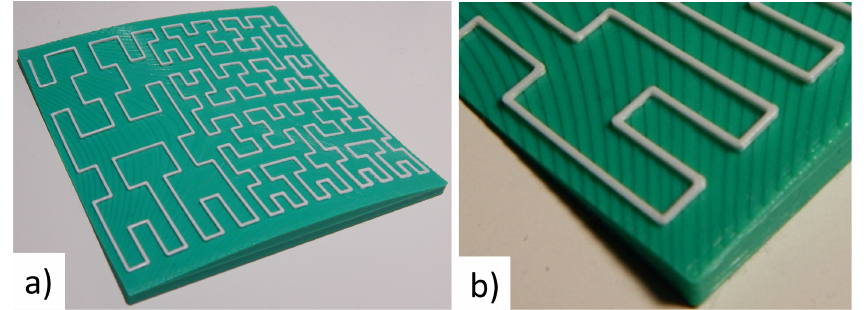
Figure 14. ( a ) Actual 3D printing of Hilbert curve projected on saddle geometry using the algorithm. ( b ) Detail of FFF printing, where the stair-stepping effect can be observed under the conformal deposition of material.